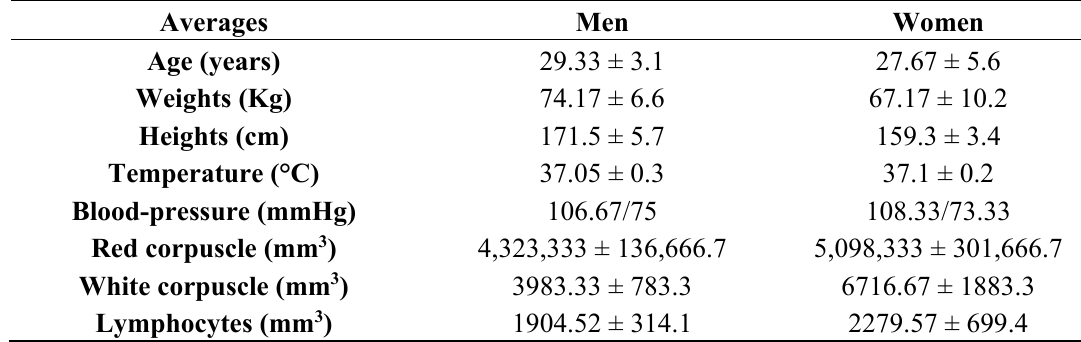
Table 2. Physical and biological data of volunteers ( n = 12); mean ±